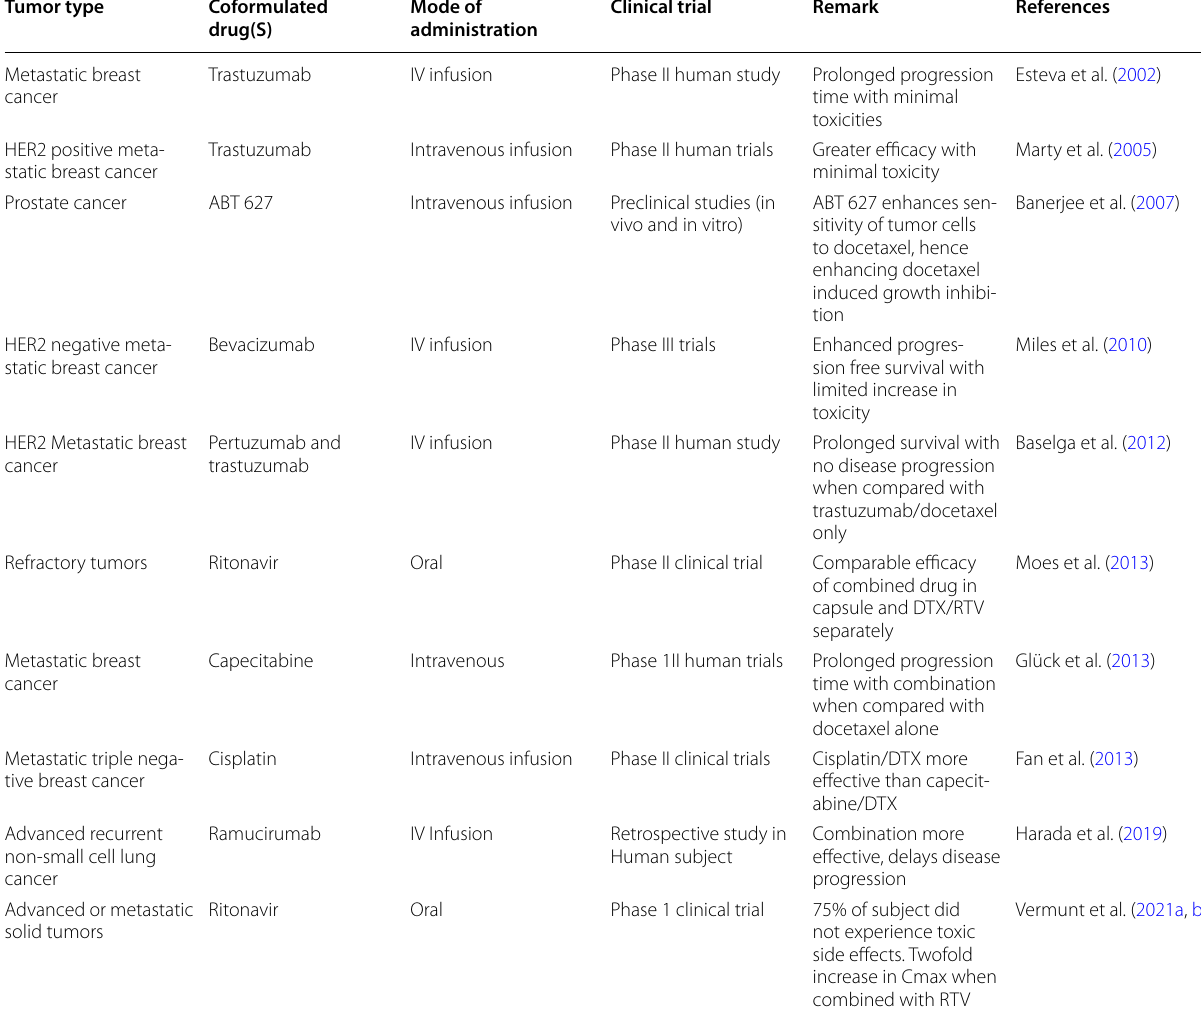
Table 1 Drugs coadministered with docetaxel for optimized chemotherapeutic action Tumor